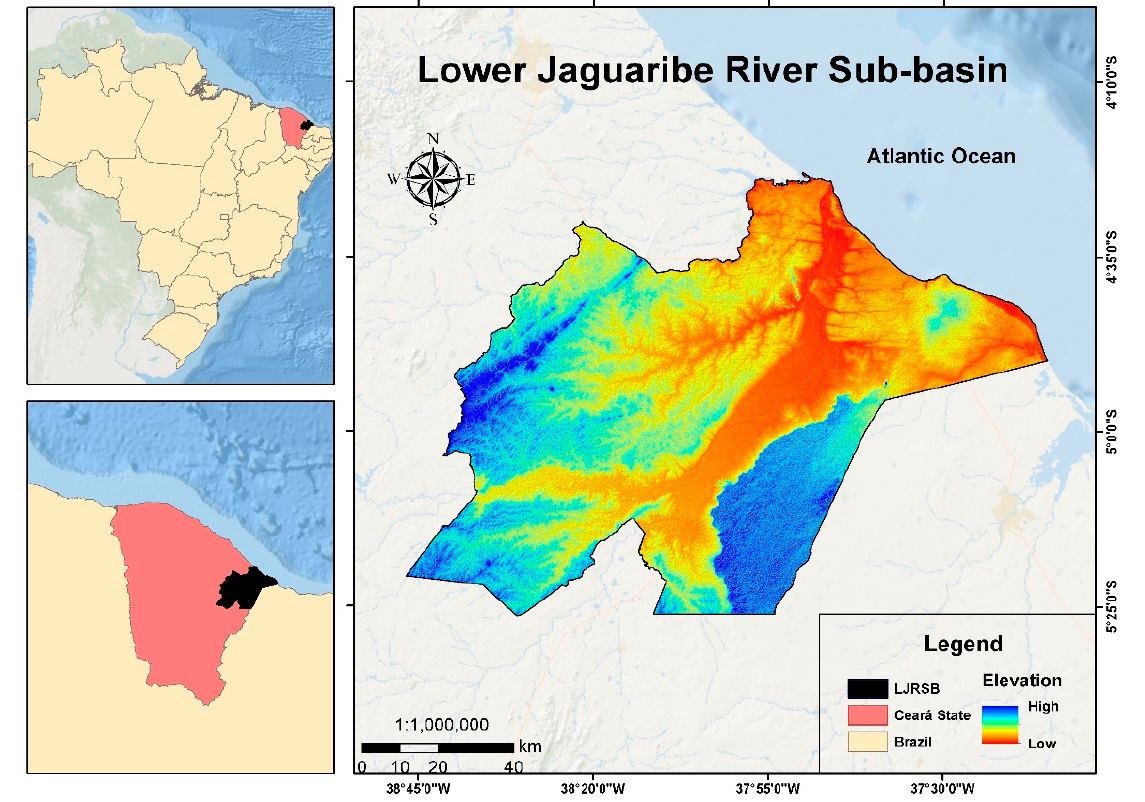
Figure 1. Map of localization in the lower Jaguaribe River sub-basin. Table 1. Mean and observed rainfall for August and September months over the LJRSB during the studied